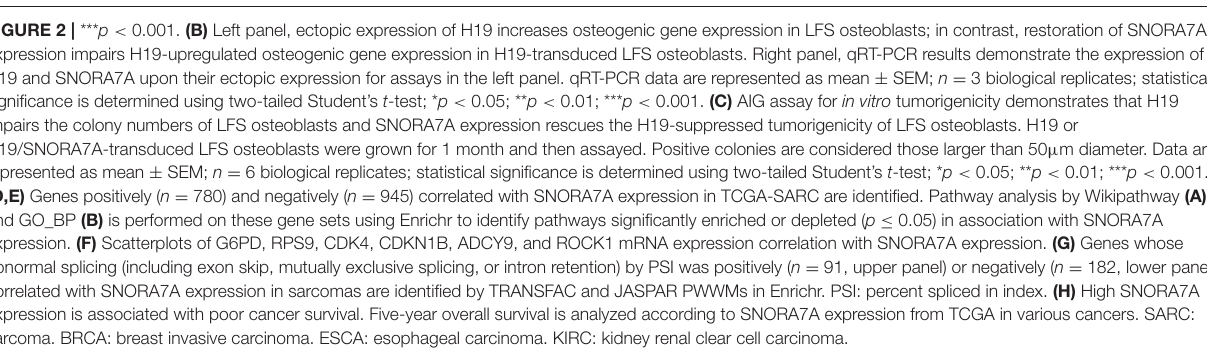
FIGURE 2 | *** p < 0.001. (B) Left panel, ectopic expression of H19 increases osteogenic gene expression in LFS osteoblasts; in contrast, restoration of SNORA7A expression impairs H19-upregulated osteogenic gene expression in H19-transduced LFS osteoblasts. Right panel, qRT-PCR results demonstrate the expression of H19 and SNORA7A upon their ectopic expression for assays in the left panel. qRT-PCR data are represented as mean ± SEM; n = 3 biological replicates; statistical significance is determined using two-tailed Student’s t -test; * p < 0.05; ** p < 0.01; *** p < 0.001. (C) AIG assay for in vitro tumorigenicity demonstrates that H19 impairs the colony numbers of LFS osteoblasts and SNORA7A expression rescues the H19-suppressed tumorigenicity of LFS osteoblasts. H19 or H19/SNORA7A-transduced LFS osteoblasts were grown for 1 month and then assayed. Positive colonies are considered those larger than 50 µ m diameter. Data are represented as mean ± SEM; n = 6 biological replicates; statistical significance is determined using two-tailed Student’s t -test; * p < 0.05; ** p < 0.01; *** p < 0.001. (D,E) Genes positively ( n = 780) and negatively ( n = 945) correlated with SNORA7A expression in TCGA-SARC are identified. Pathway analysis by Wikipathway (A) and GO_BP (B) is performed on these gene sets using Enrichr to identify pathways significantly enriched or depleted ( p ≤ 0.05) in association with SNORA7A expression. (F) Scatterplots of G6PD, RPS9, CDK4, CDKN1B, ADCY9, and ROCK1 mRNA expression correlation with SNORA7A expression. (G) Genes whose abnormal splicing (including exon skip, mutually exclusive splicing, or intron retention) by PSI was positively ( n = 91, upper panel) or negatively ( n = 182, lower panel) correlated with SNORA7A expression in sarcomas are identified by TRANSFAC and JASPAR PWWMs in Enrichr. PSI: percent spliced in index. (H) High SNORA7A expression is associated with poor cancer survival. Five-year overall survival is analyzed according to SNORA7A expression from TCGA in various cancers. SARC: sarcoma. BRCA: breast invasive carcinoma. ESCA: esophageal carcinoma. KIRC: kidney renal clear cell